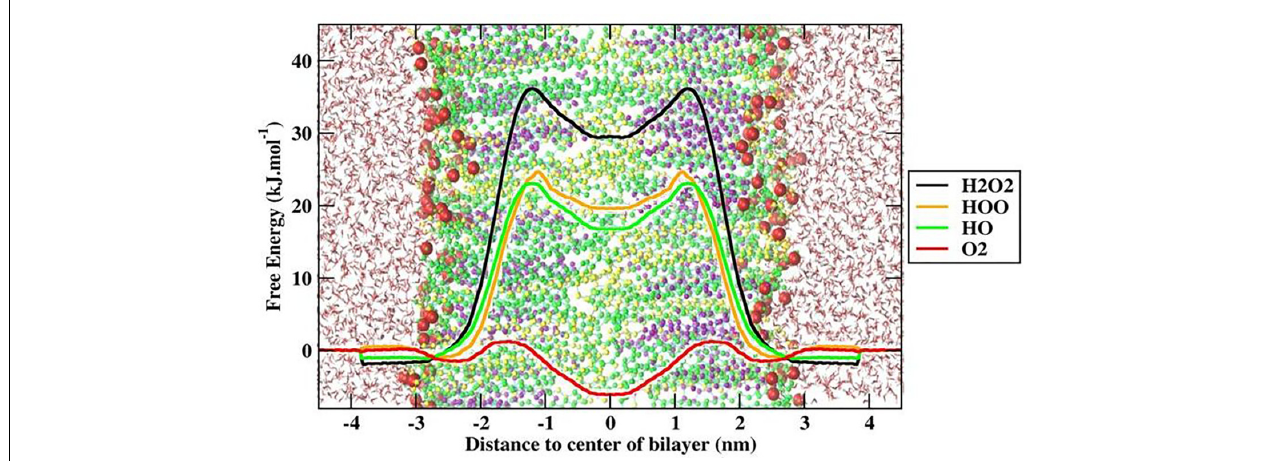
FIGURE 8 | Free energy profile (FEP) of different ROS across skin-lipid bilayer (CER-CHO-FFA) membrane.